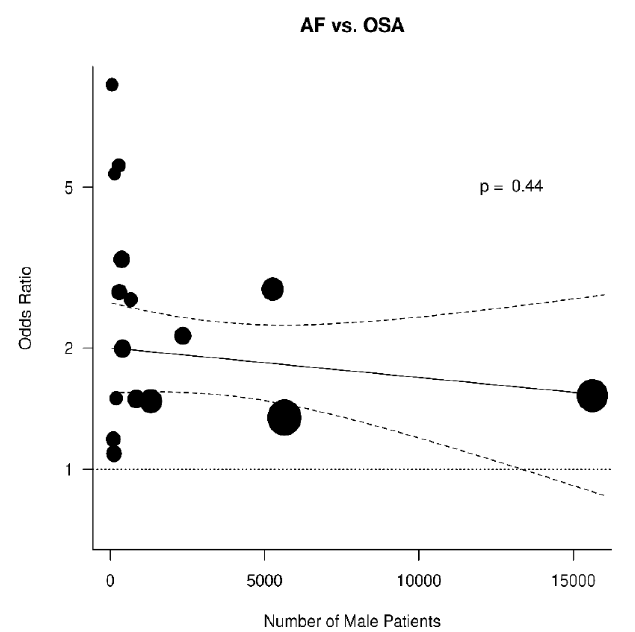
Figure 4. Effect of sex in the odds ratio for atrial fibrillation (AF) in patients with obstructive sleep apnea (OSA).